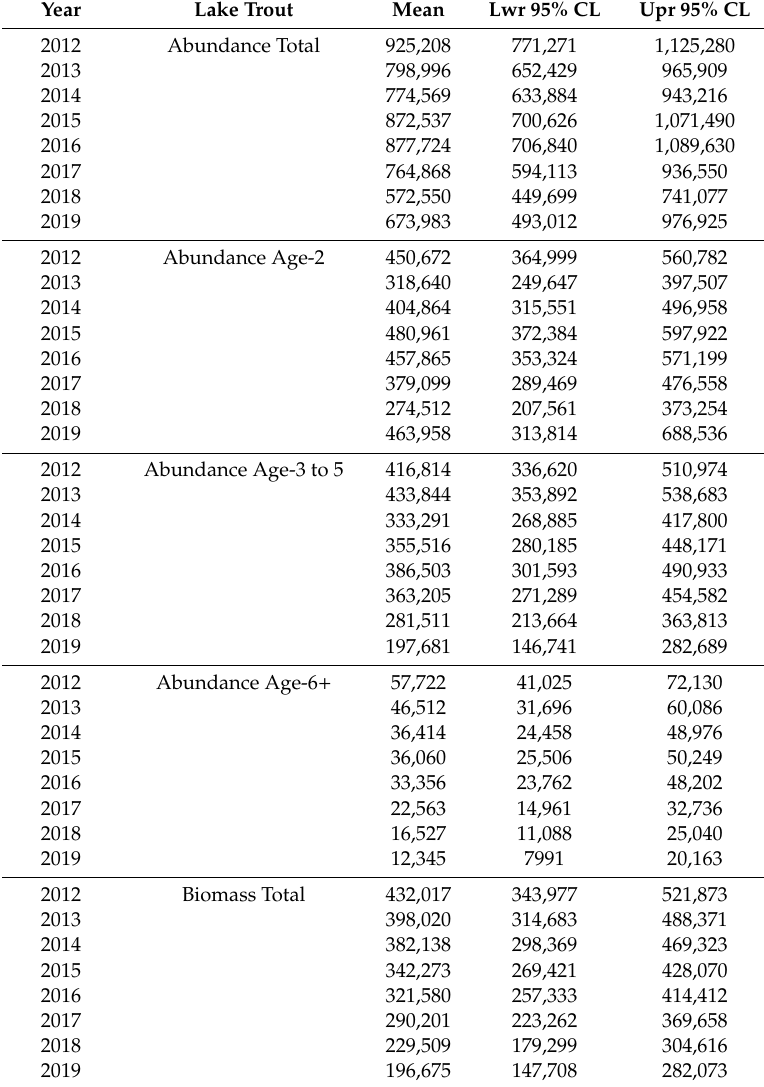
Table A5. Mean annual total abundance and biomass, and abundances of age-2, age-3 to age-5, and age-6 + lake trout at the start of the year from 2012 through 2019 with lower (Lwr) and upper (Upr) 95% confidence limits (CL) estimated using a statistical catch-at-age (SCAA) model